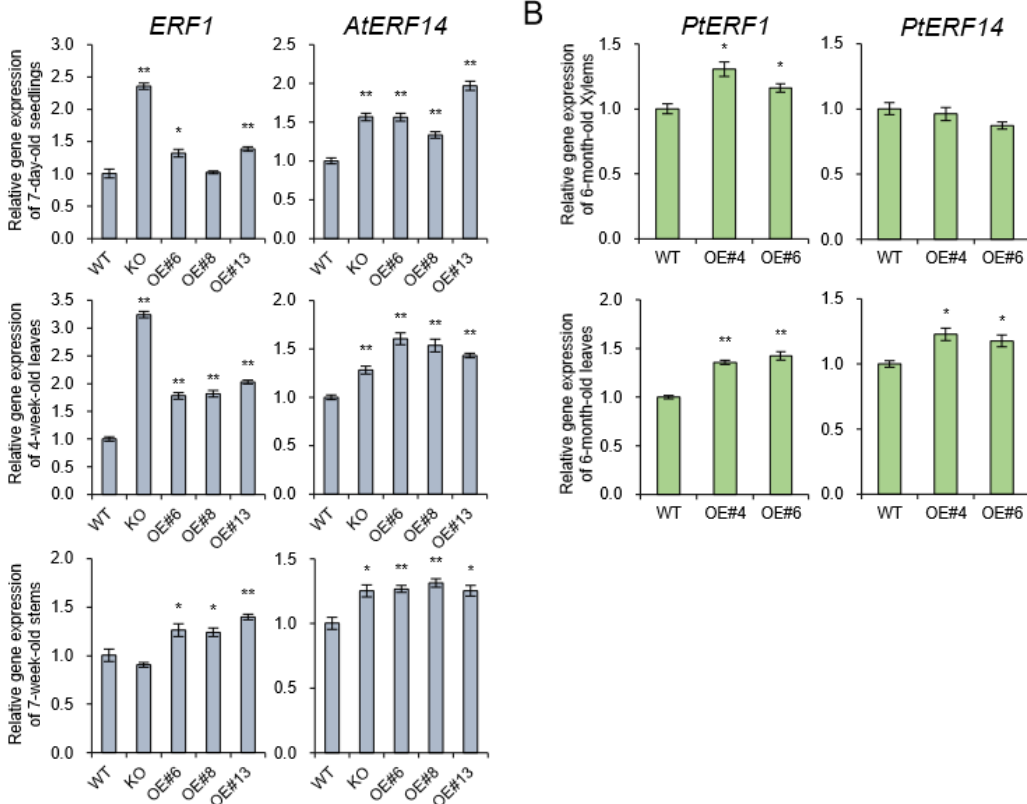
Figure 8. Expression of ethylene-responsive genes in Arabidopsis and poplar. ( A ) The transcript levels of ERF1 and AtERF14 which is upregulated by ethylene [29] were quantified by qRT-PCR in seedlings, leaves, and stems of AtpPLAIIIα -OE lines of Arabidopsis . ( B ) Expression levels of PtERF1 and PtERF14 in stems of AtpPLAIIIα -OE lines of poplar. Each datum represents the average ± SE from three independent replicates at P < 0.05 (*) and P < 0.01 (**), respectively.